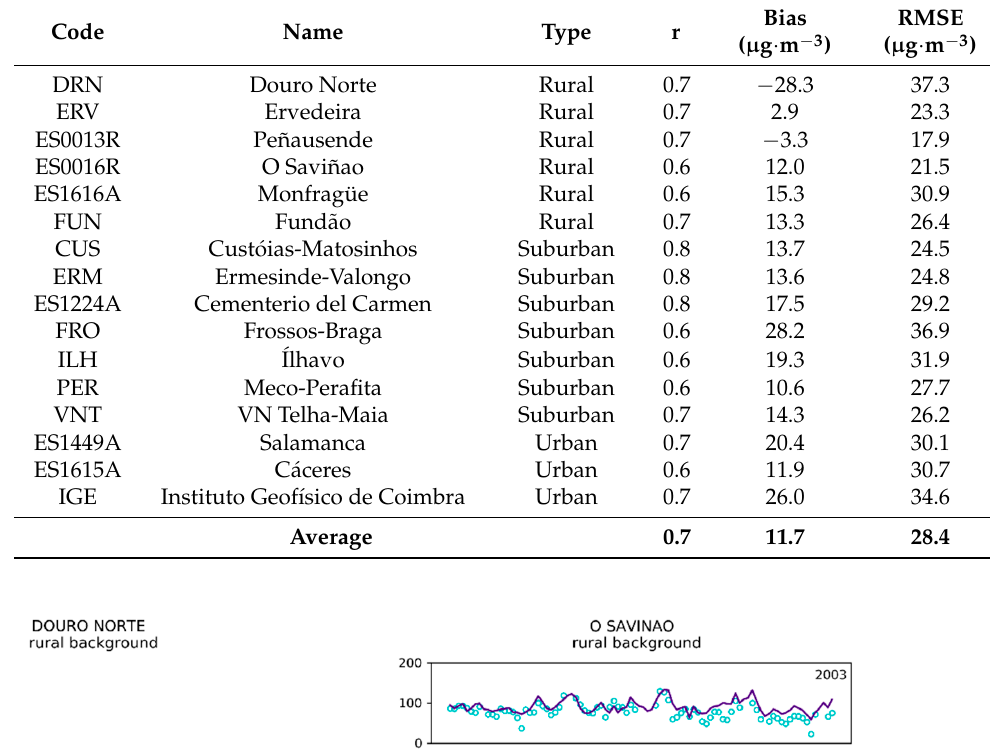
Figure 5. Note that Douro Norte station began measuring in 2004. Four “representative” sites were selected to cover the different type of monitoring stations. Table 4. Correlation coefficient, bias, RMSE for each station, for O 3 .